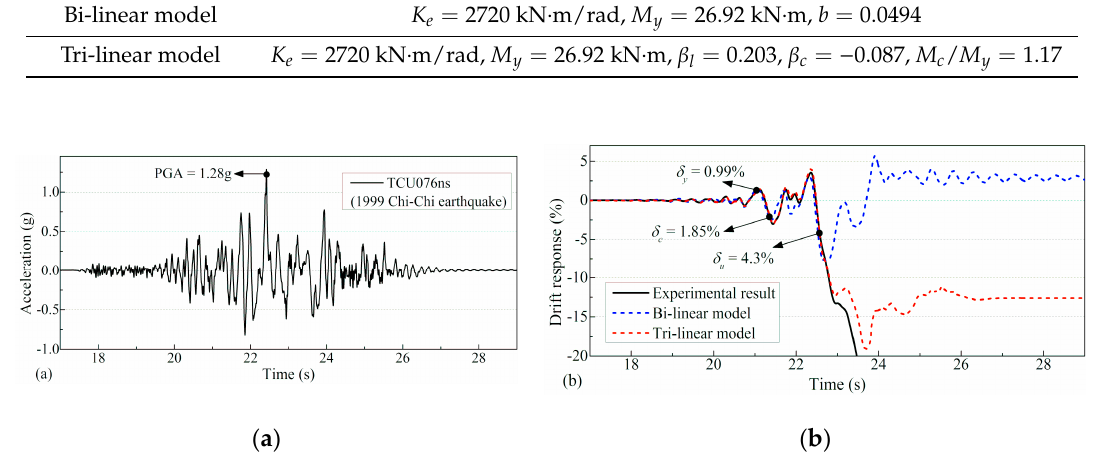
Figure 15. Drift response comparison of the frame obtained from test and ANN-based LP model: ( a )